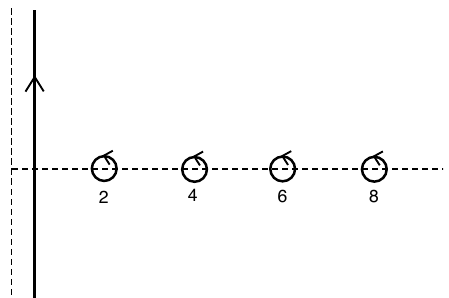
Figure 4. The contour of integration C in the complex h